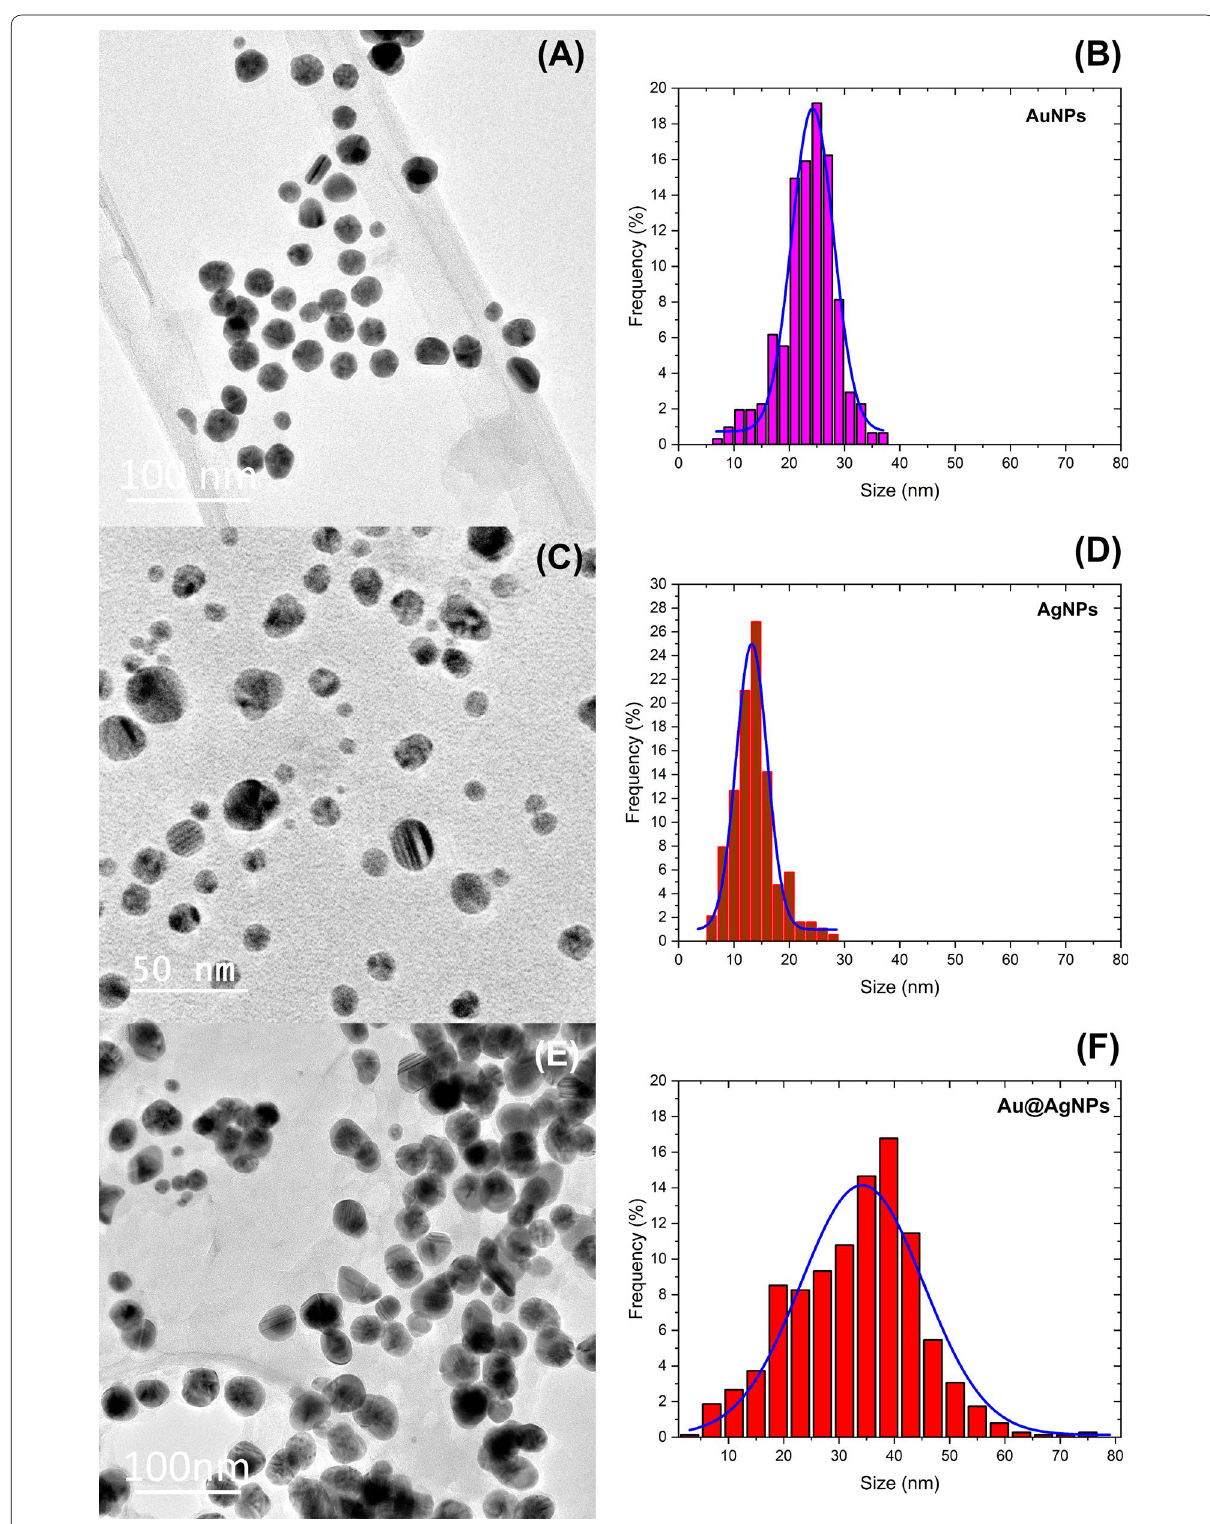
Fig. 4 TEM and size distribution of AuNPs in ( a ) and ( b ), AgNPs in ( c ) and ( d ), and Au@AgNPs in ( e ) and ( f